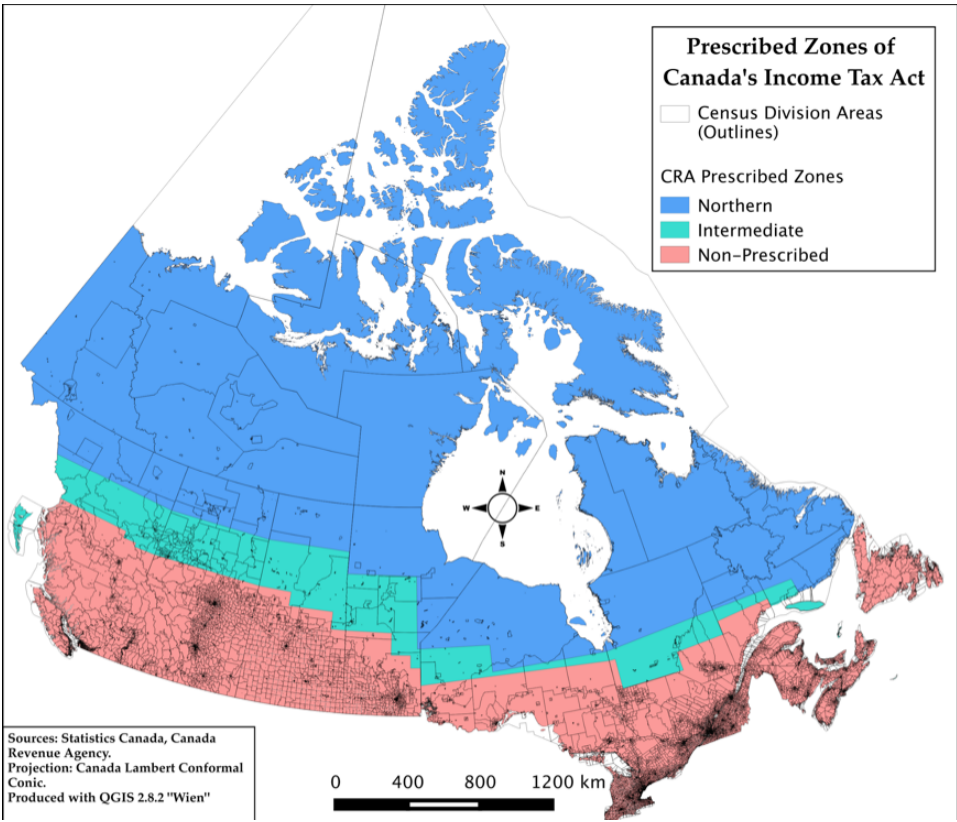
Figure 1: Northern, rural and remote